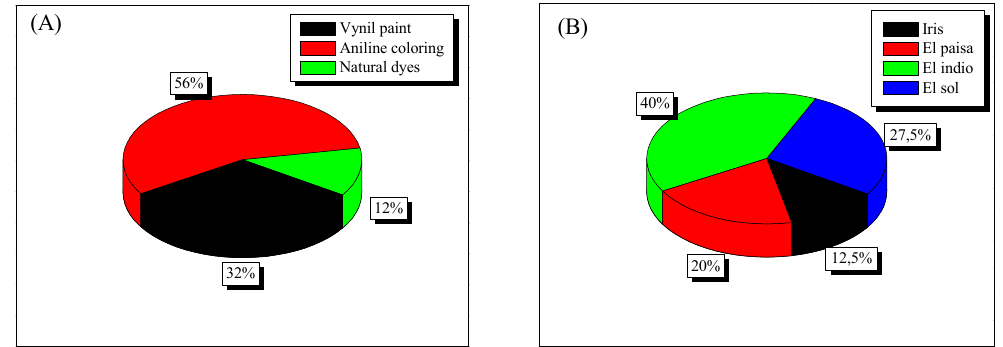
Figure 6. ( A ) Kind of dyestuffs and ( B ) commercial dyestuffs usually applied in Colombian handicrafts factories.